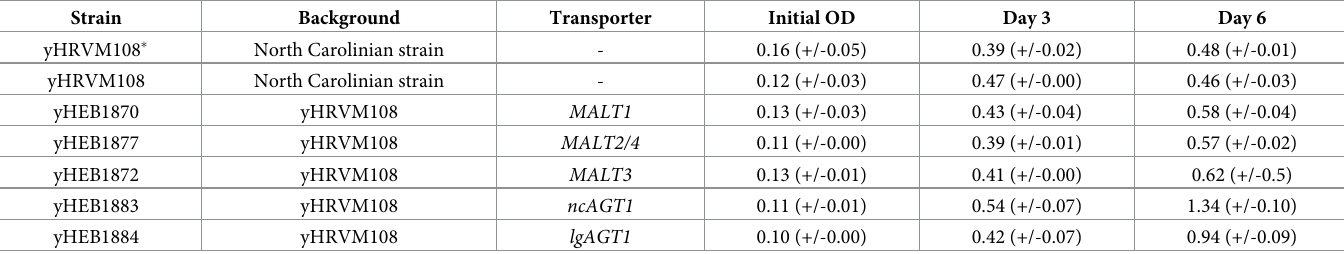
Table 1. Heterologous expression of S . eubayanus MALT genes. Strain